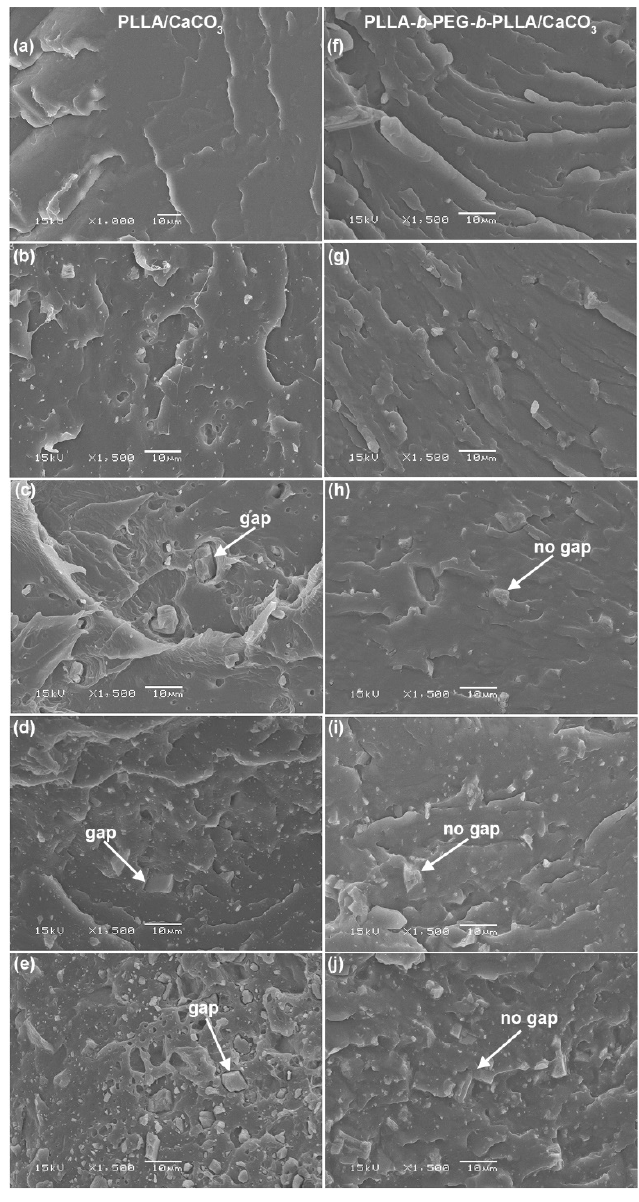
Figure 8. SEM images of cryogenic film fractures with PLLA/CaCO 3 ratios of ( a ) 100/0, ( b ) 95/5, ( c ) 90/10, ( d ) 80/20, and ( e ) 70/30 %wt, as well as with PLLA- b -PEG- b -PLLA/CaCO 3 ratios of ( f ) 100/0, ( g ) 95/5, ( h ) 90/10, ( i ) 80/20, and ( j ) 70/30 %wt (all bar scales = 10 μ m).